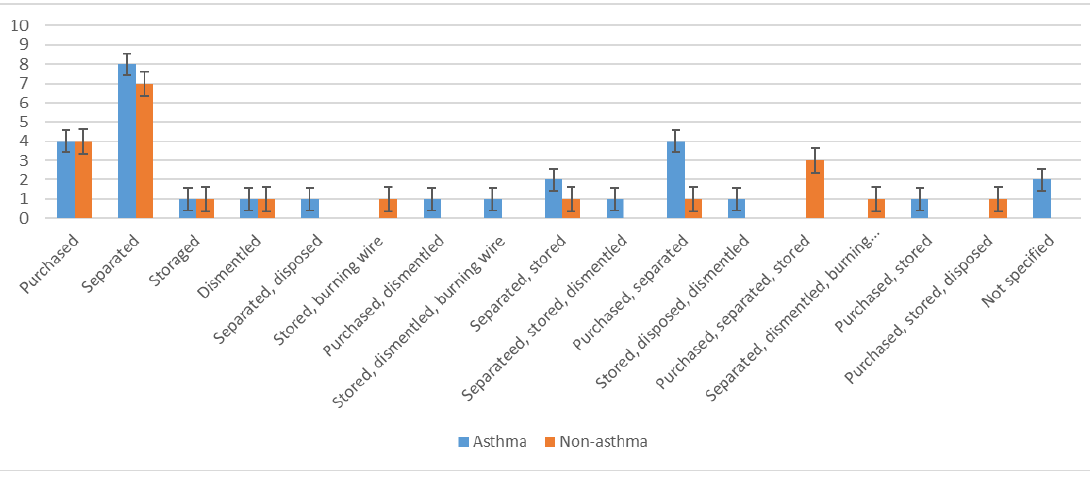
Figure 3. Participant involvement in specific steps of electronic waste handling, stratified by asthma status.